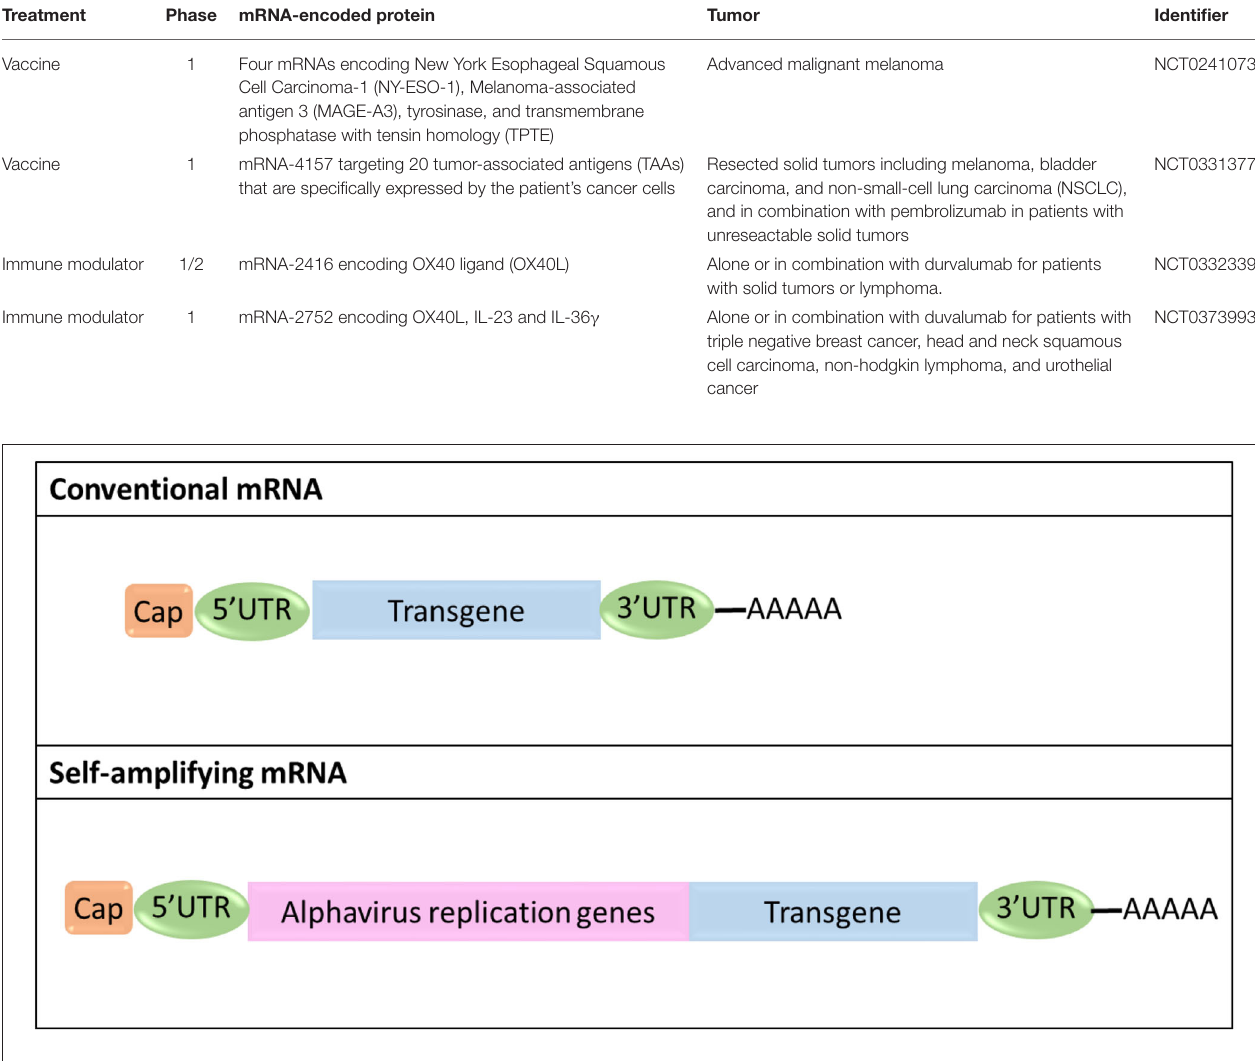
is focusing on the isolation of specific primary DC subsets, due to their superior immunostimulatory functions (Baldin et al.,